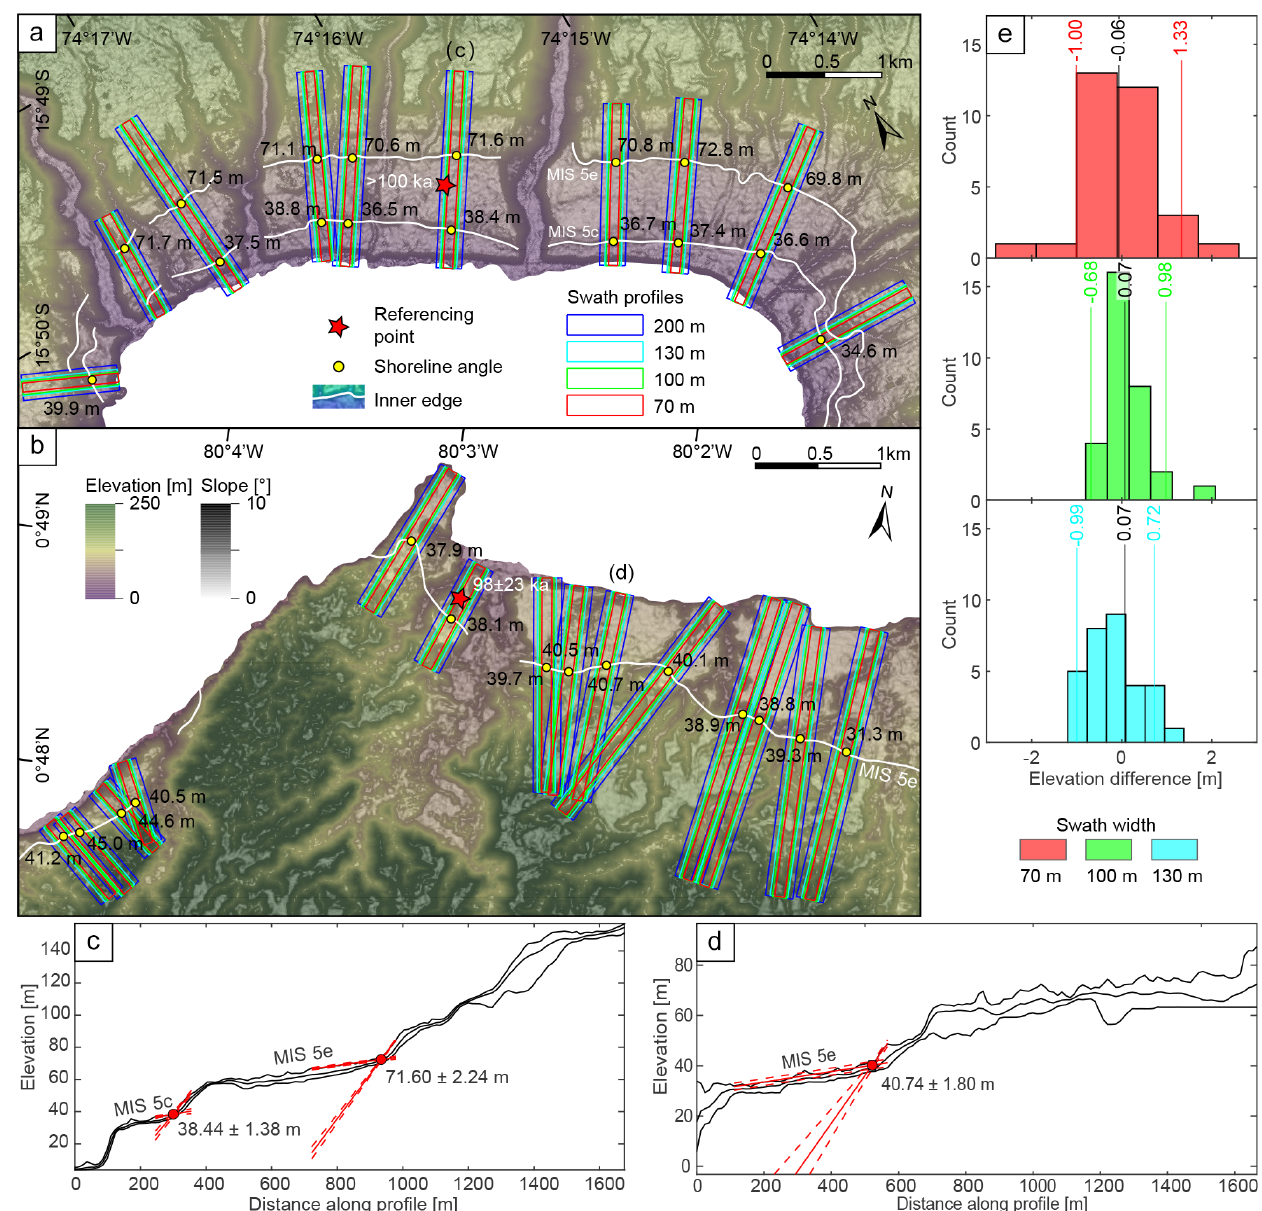
Figure 2. Orthometrically corrected TanDEM-X and slope map of (a) Chala Bay in south-central Peru and (b) Punta Galera in northern Ecuador with mapped inner shoreline edges of the MIS 5e and 5c terrace levels. Colored rectangles represent swath-profile boxes of various widths that were placed perpendicular to the inner edges for the subsequent estimation of terrace elevation in TerraceM. The red star indicates the referencing point with the age constraint for the respective area (Pedoja et al., 2006b; Saillard, 2008). Panels (c) and (d) show the estimation of shoreline-angle elevations in TerraceM by intersecting linear-regression fits of the paleo-cliff and paleo-platform (200m wide swath profiles). (e) Histograms of elevation differences measured in both areas for various swath widths (70, 100, and 130m) with respect to the 200m wide reference swath profile (blue). Vertical lines indicate median values and standard deviations (2 σ